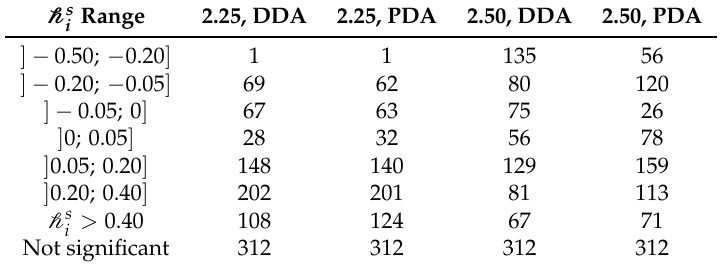
Table 3. The number of nodes subdivided by range of pressure deficit and surplus, as appear in Figures 7 and 9, that is, P c equal to 2.25 or 2.5.